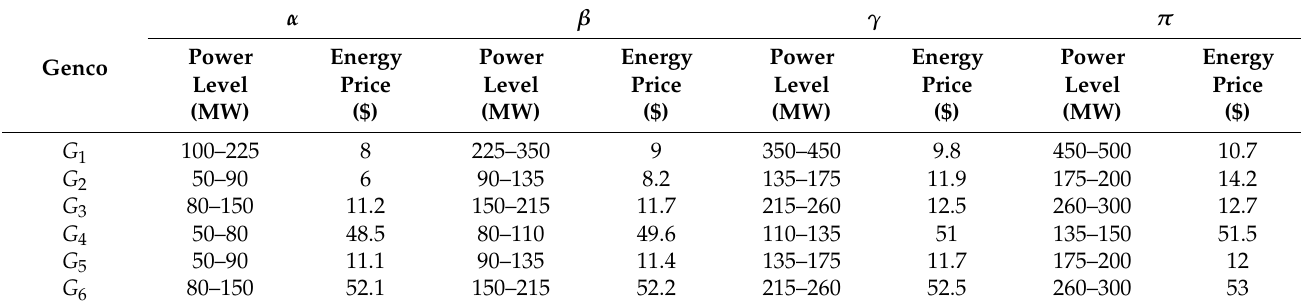
Table 2. Genco offers.